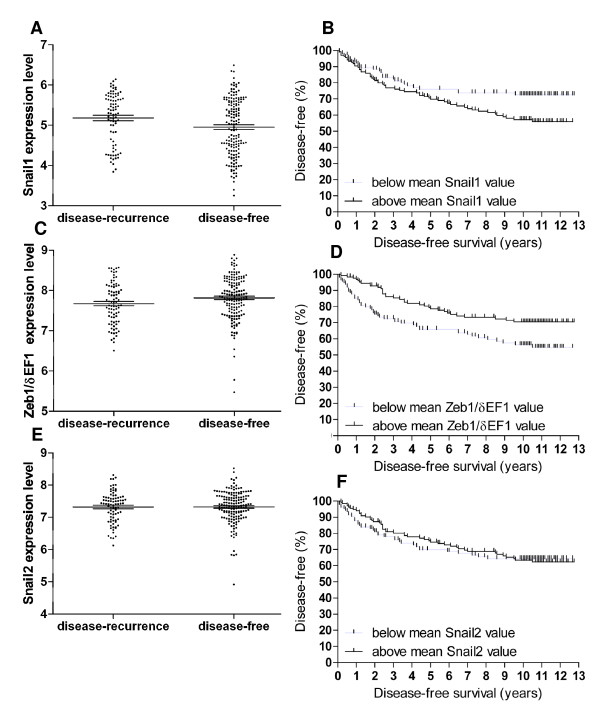
Statistical interrogation of the GSE4922 microarray dataset of human primary breast cancers. Expression levels of Snail1 (A), Zeb1/δEF1 (C) and Snail2 (E) were compared between tumours from patients who remained disease-free and those from patients who had a disease-recurrence event (local, regional, distant or death from breast cancer) across the 242 patients with a non-zero disease-free survival time in the GSE4922 microarray dataset [39]. Snail1 was expressed more highly in tumours from patients who had a disease-recurrence event, as determined by Mann-Whitney test (p = 0.017). Zeb1/δEF1 was expressed more highly in tumours from patients who remained disease-free, as determined by Mann-Whitney test (p = 0.026). Kaplan-Meier analysis of disease-free survival comparing patients with a Snail1 (B), Zeb1/δEF1 (D) or Snail2 (F) expression level above or below the mean expression level. Overall patients with an above mean Snail1 expression value had a poorer clinical outcome as determined by Gehan-Breslow-Wilcoxon test (p = 0.031), as did those patients with a below mean Zeb1/δEF1 expression value as determined by Gehan-Breslow-Wilcoxon test (p = 0.004).